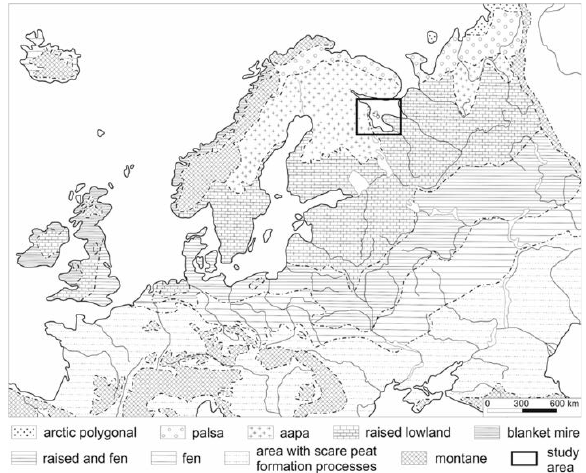
Figure 1. Map of the zonality of European mires (Żurek 1984), showing location of the s tudy